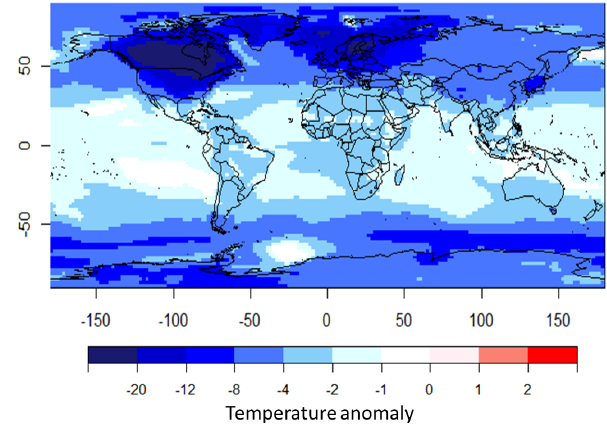
Figure 2. Reconstruction of the Last Glacial Maximum surface air temperature anomalies ( ◦ C) based on multi-model regression. Data source: Annan and Hargreaves (2013).